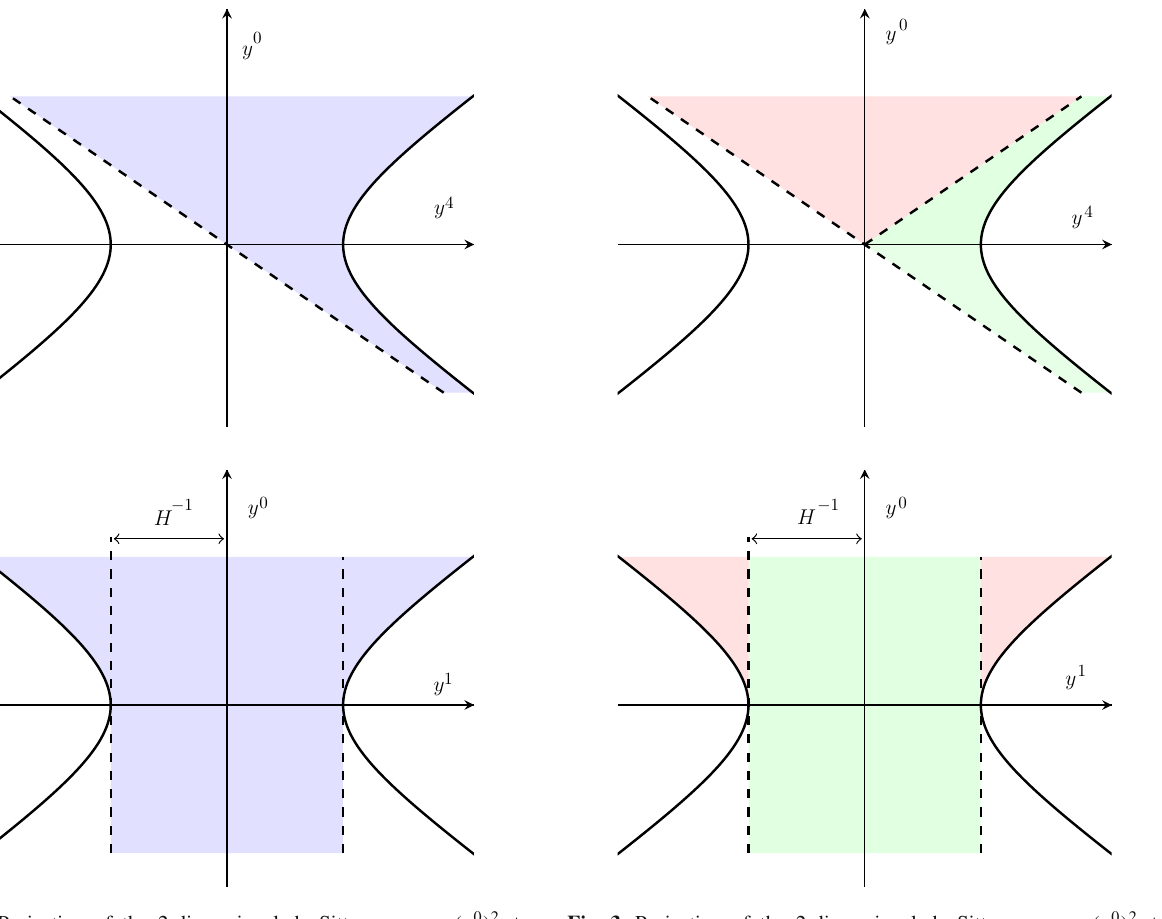
Fig. 3 Projection of the 2-dimensional de Sitter space, − ( y 0 ) 2 + ( y 1 ) 2 + ( y 4 ) 2 = H − 2 , as covered by the static-type coordinates (21) and (23) denoted with green and red, respectively, on the ( y 4 , y 0 ) -plane (top) and the ( y 1 , y 0 ) -plane